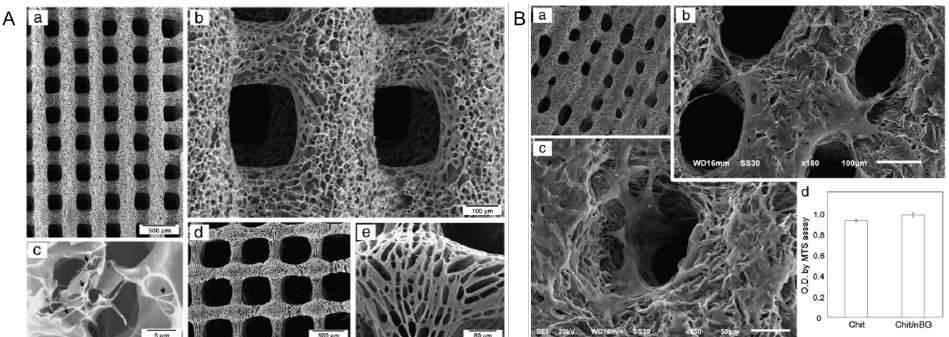
Figure 7. SEM morphologies of the robotic-dispensed scaffolds for bone tissue engineering. A ( a – c ) Chitosan/nanobioactive glass scaffolds and ( d , e ) Chitosan scaffold at different magnifications. B ( a – c ) Cells grown on chitosan/nanobioactive glass scaffolds for 3 days at different magnifications d Cell proliferative potential of chitosan and chitosan/nanobioactive glass scaffolds measured by MTS assay Reproduced from [107] with permission from Copyright 2011, Elsevier.